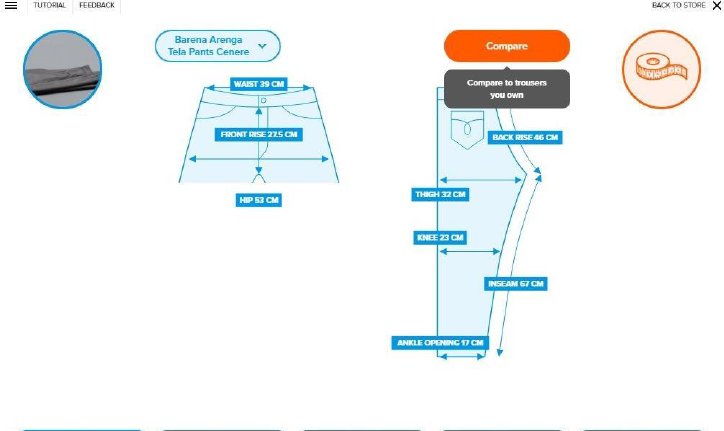
Figure 1. An example of clothing measures for virtual fitting with the use of the Virtusize